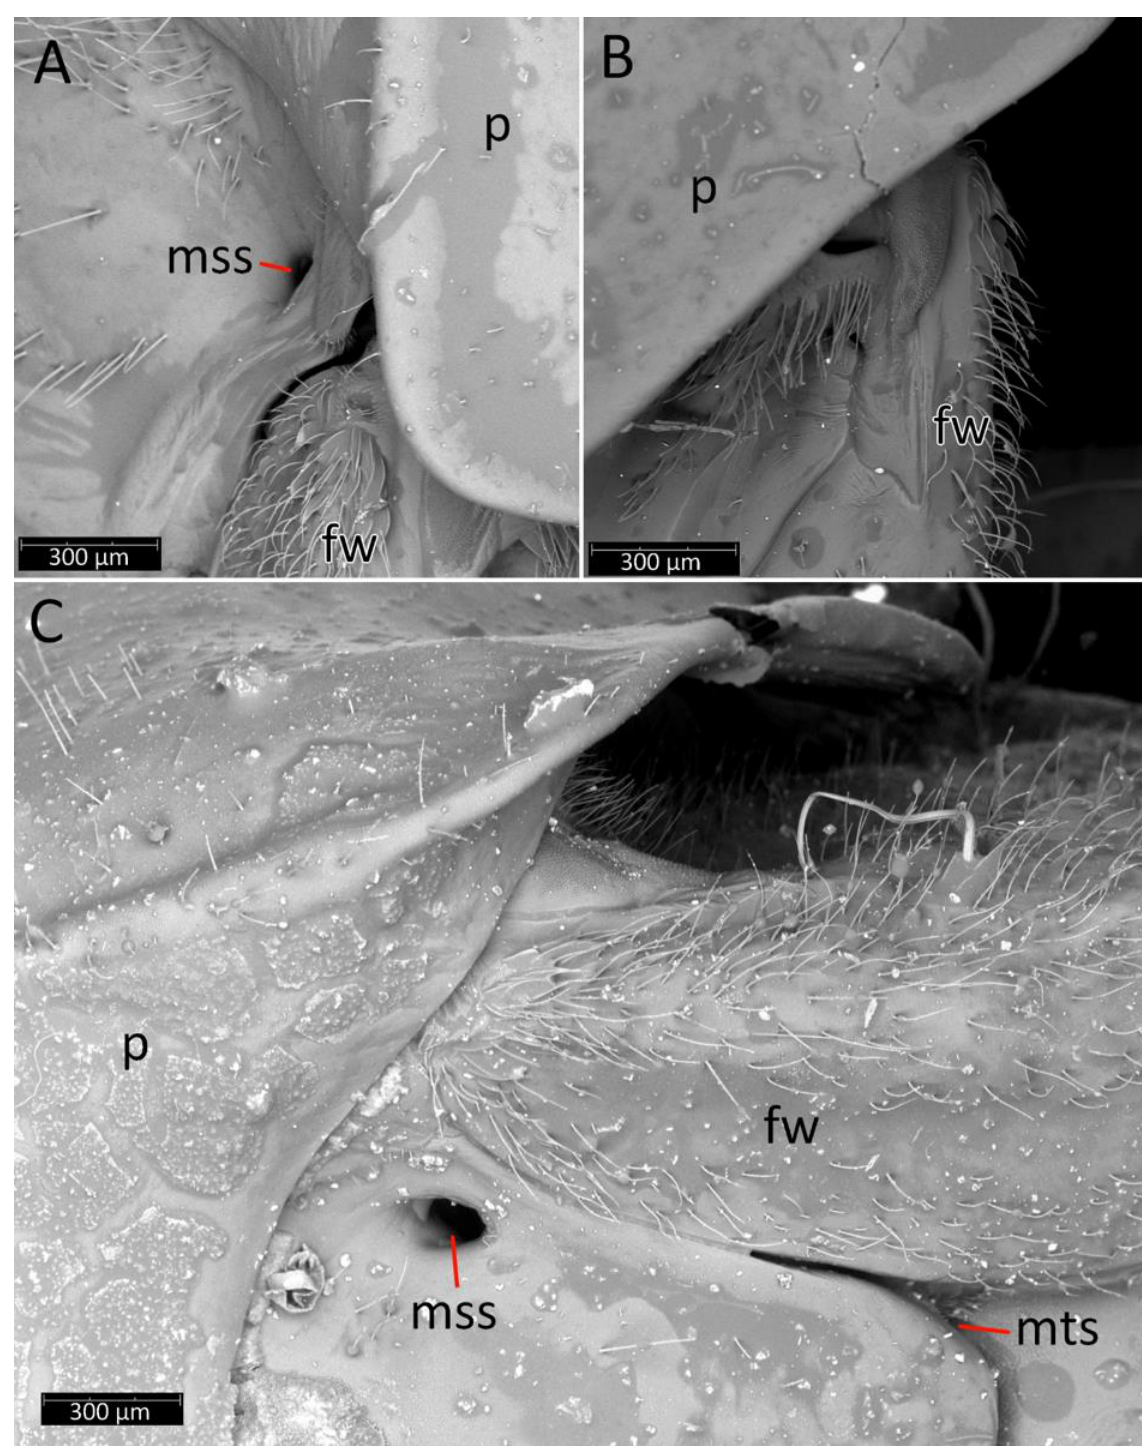
Figure 14. Phonoctonus luridus Miller, 1950. ( A ) mesothoracic spiracle with the left fore wing’s base, dorso-lateral view. ( B ) Structure of central depression of scutellum with sensilla, dorsal view. ( C ) Meso- and metathorax with spiracles, lateral view. fw — fore wing; mss — mesothoracic spiracle; mts — metathoracic spiracle; p — pronotum.